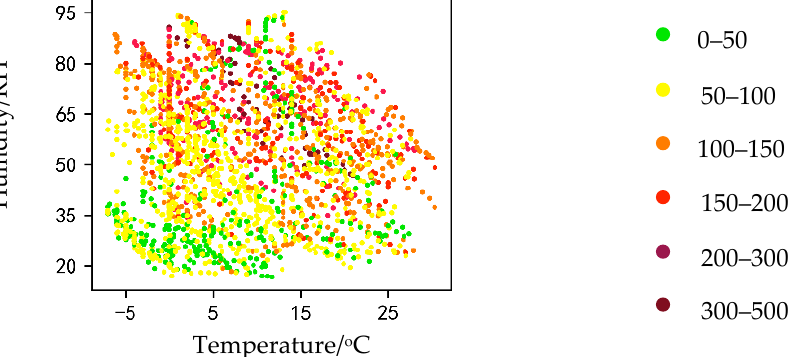
Figure 2. Correlation between AQI with temperature and humidity.